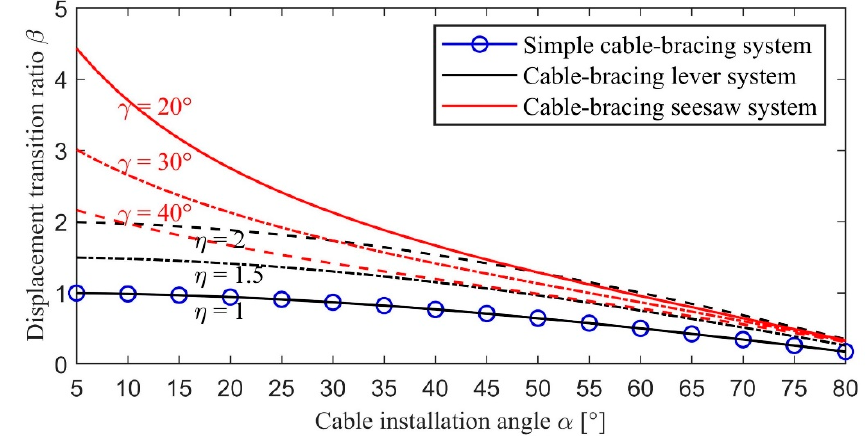
Figure 3. The displacement transition ratio of the cable-bracing inerter system.